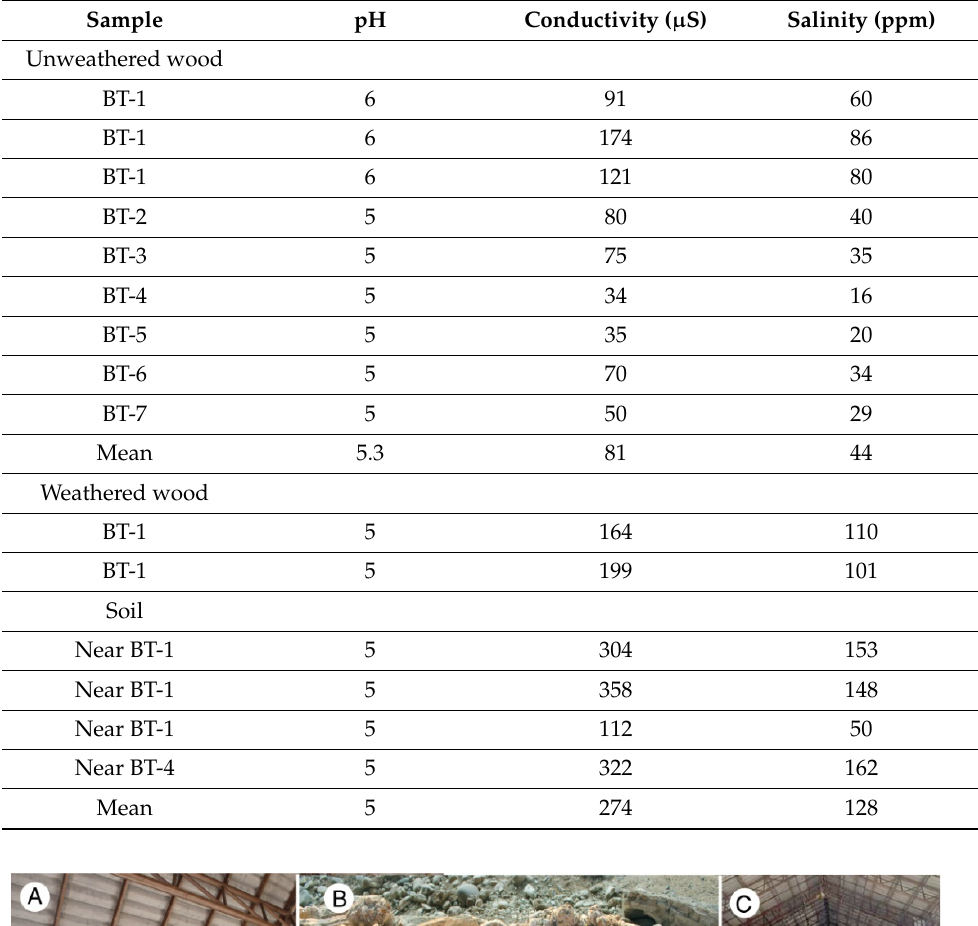
Table 3. Measurements of pH, conductivity, and salinity for Tak samples.